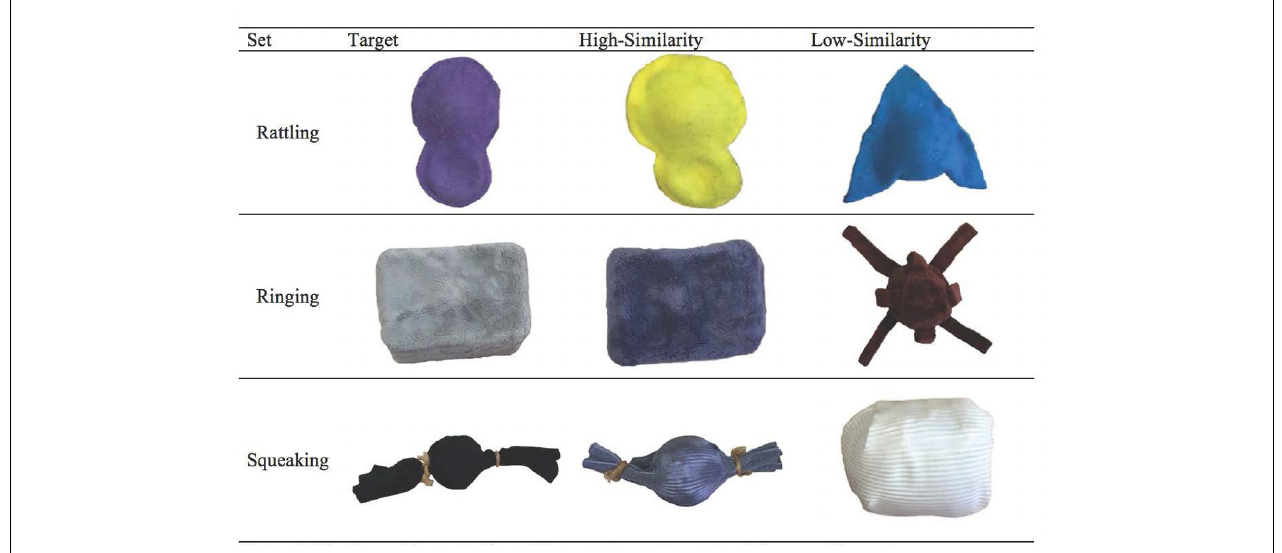
FIGURE 1 | The three object sets: the ringing set, the rattling set, and the squeaking set. Within each object set there was a target object (top center), high-similarity object (bottom left), and low-similarity object (bottom right).